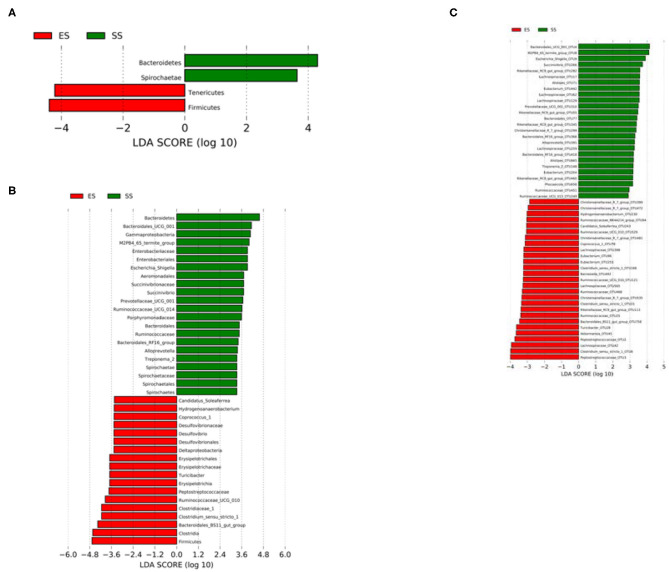
Differences in the rumne microbiota between juvenile and sub-adult Tibetan sheep. Linear discriminant analysis (LDA) effect size (LEfSe) results show that bacterial phyla (A)/genera (B)/OTUs (C) were significantly different in abundance between the two age stages.